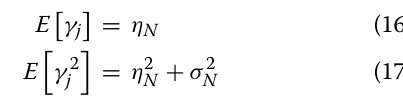
Fig. 2 Clock model